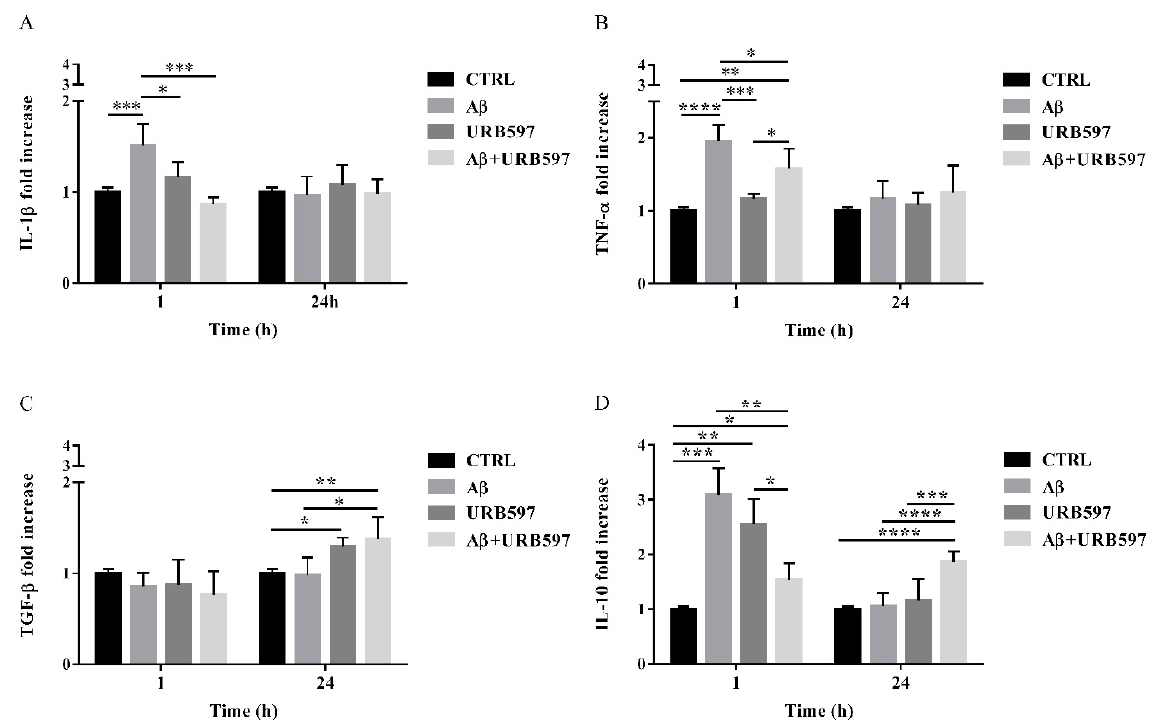
Figure 8. The mRNA expression of different inflammatory cytokines such as IL-1 β ( A ), TNF- α ( B ), TGF- β ( C ), and IL-10 ( D ), monitored by qPCR and normalized to 18S ribosome subunit. Data are shown as mean ± SD from three independent experiments performed in triplicate. Expression profiles were determined using the 2 − ∆∆ CT method. * p < 0.05, ** p < 0.01, *** p < 0.001, **** p < 0.0001 .